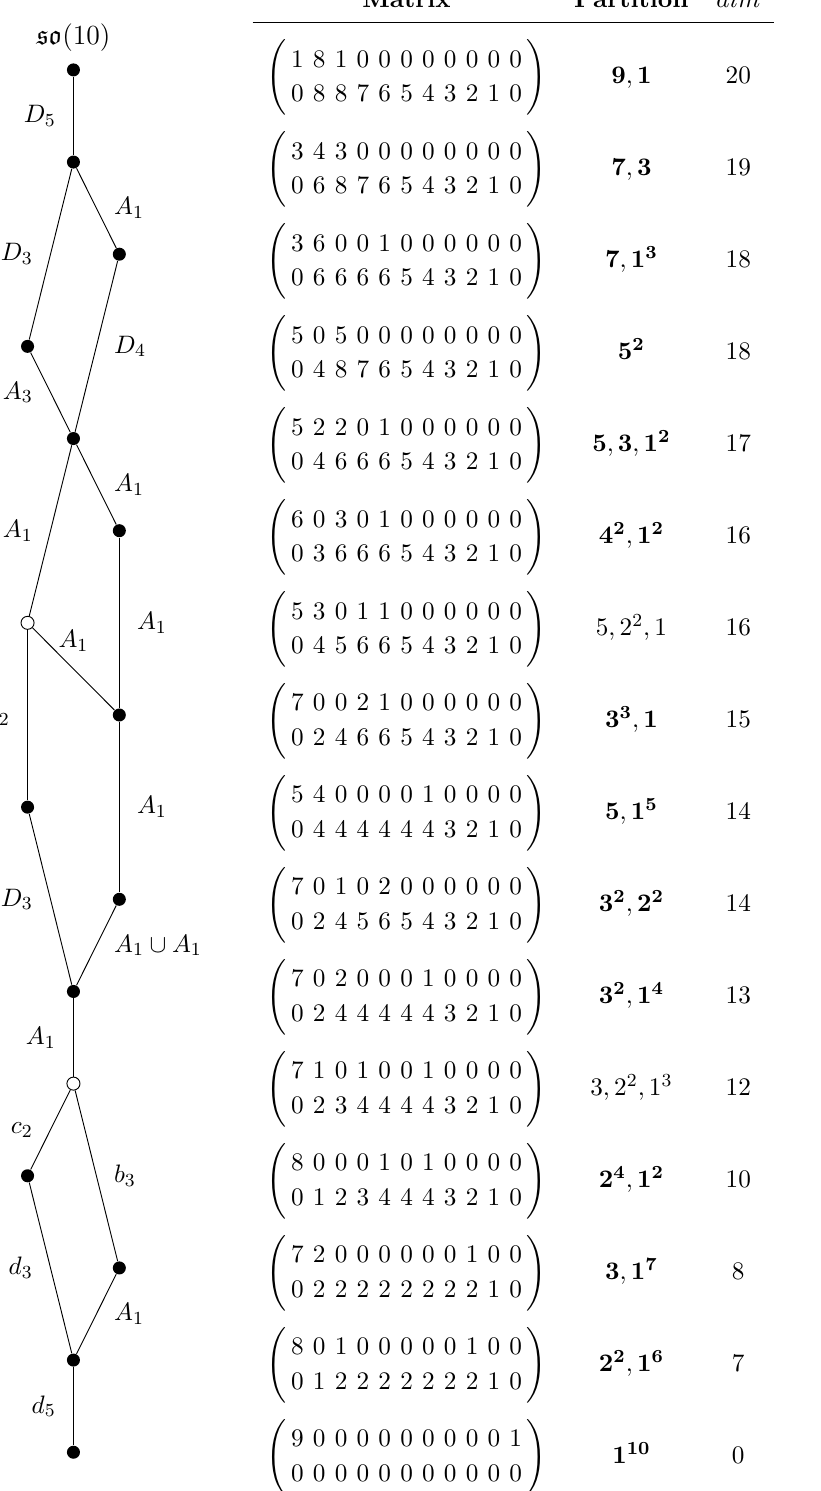
Table 17. Results obtained applying the matrix formalism to so